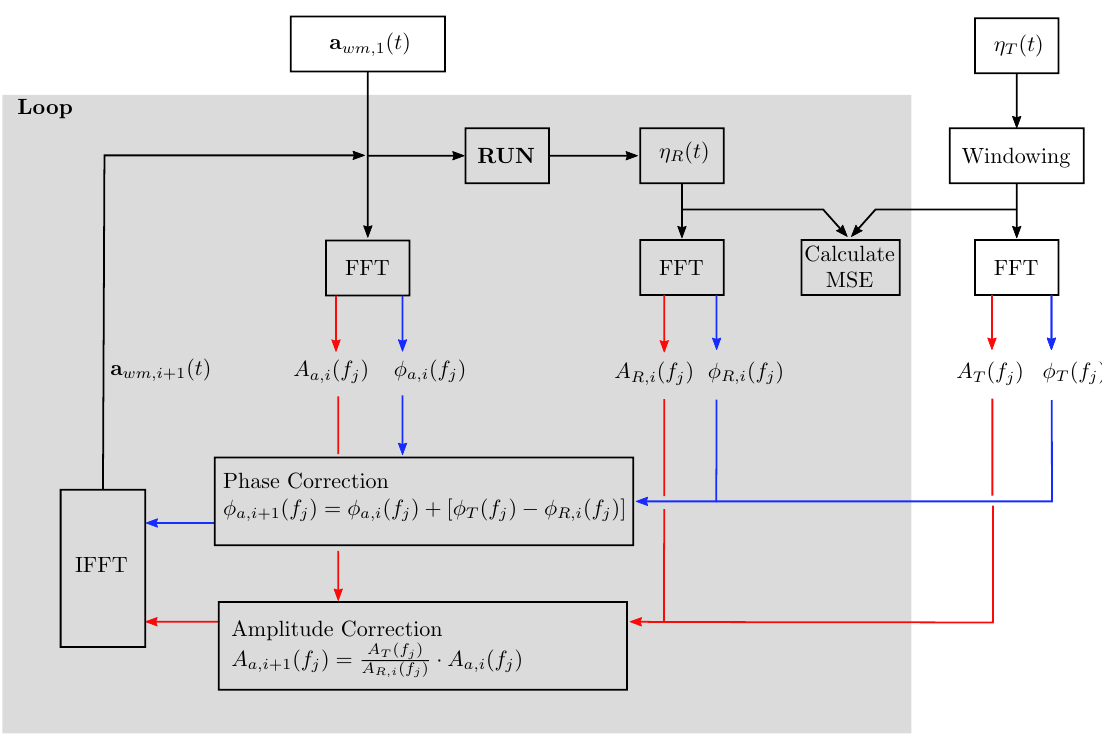
Figure 1. Schematic of the calibration